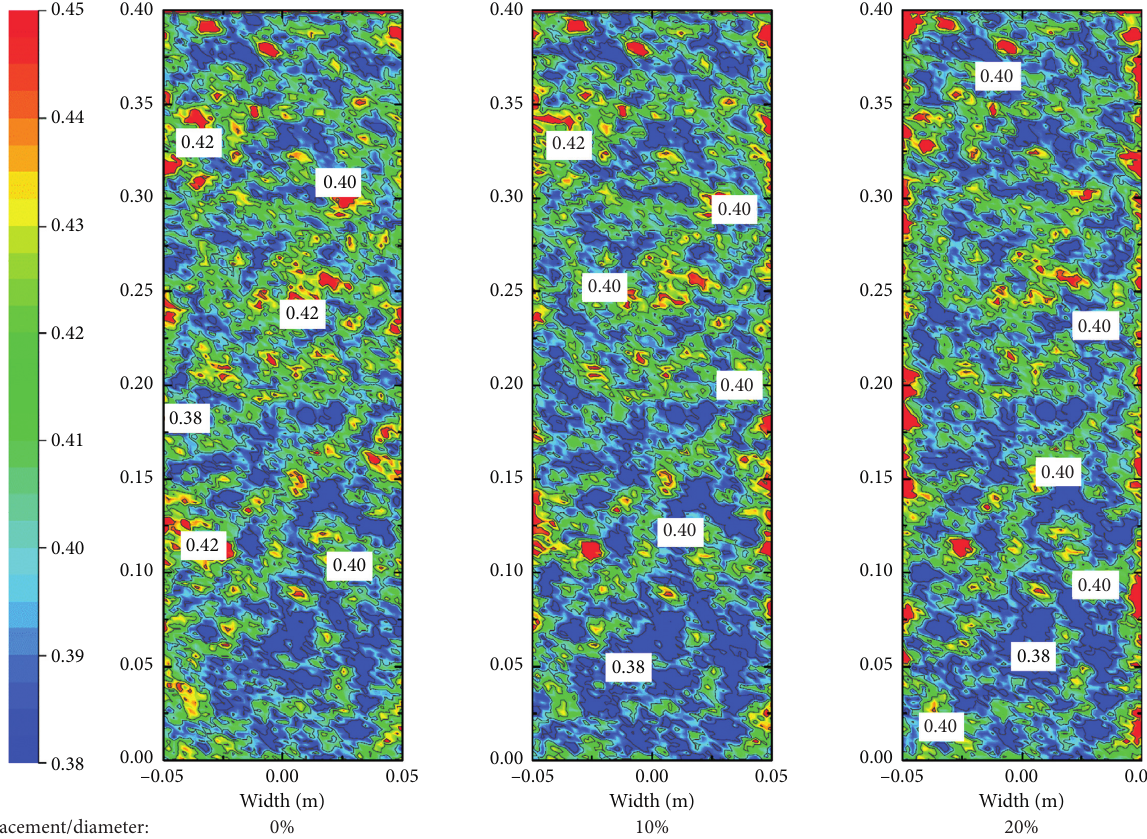
Figure 11: Porosity distribution inside the soil plug ( D � 10 cm and L / D �